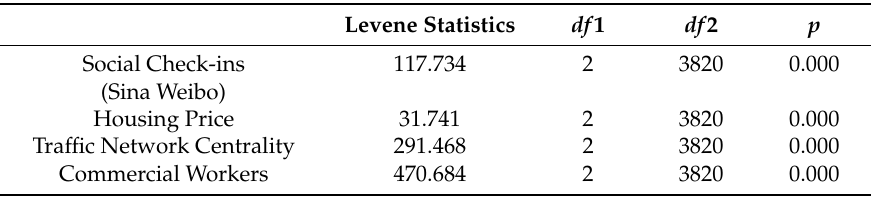
Table 1. Homogeneity of variance